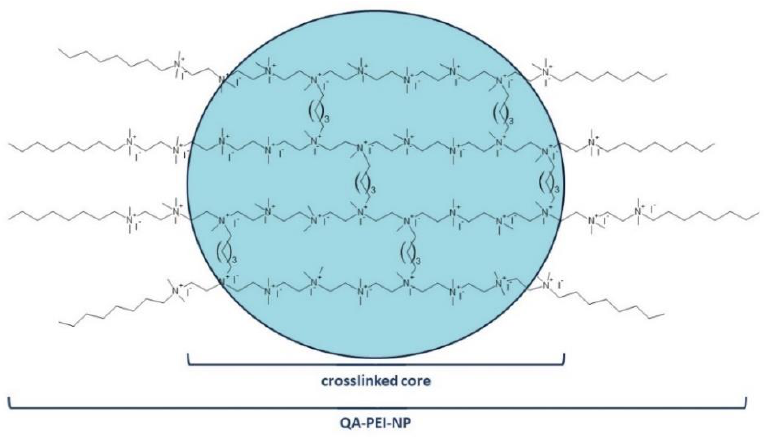
Figure 1. The chemical structure of QA-PEI-NPs.